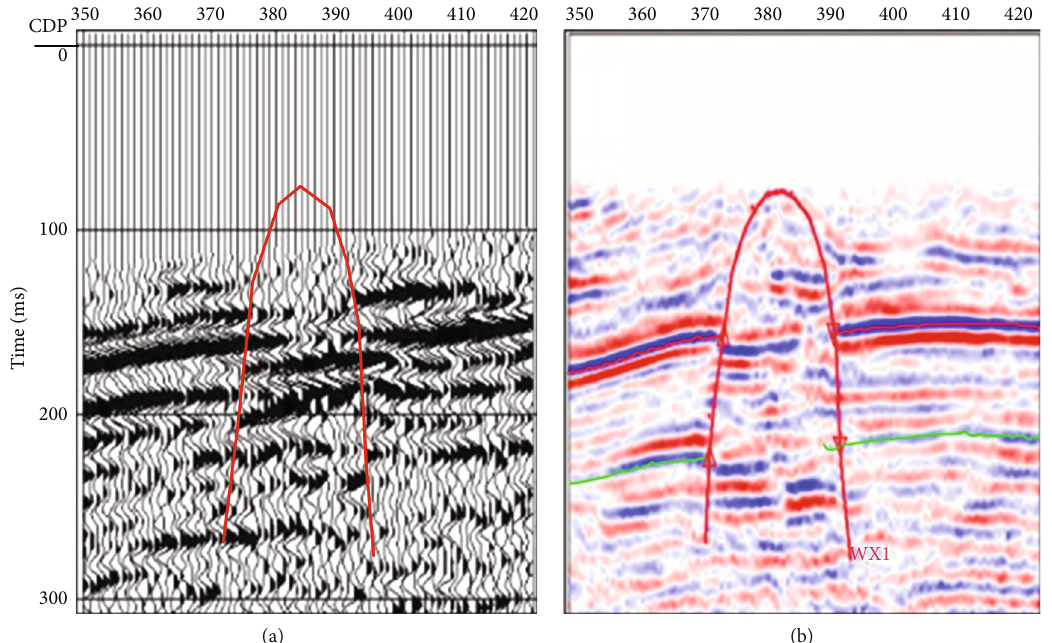
Figure 6: Collapsed column in a seismic pro fi le: (a) original recording pro fi le and (b) velocity pro fi